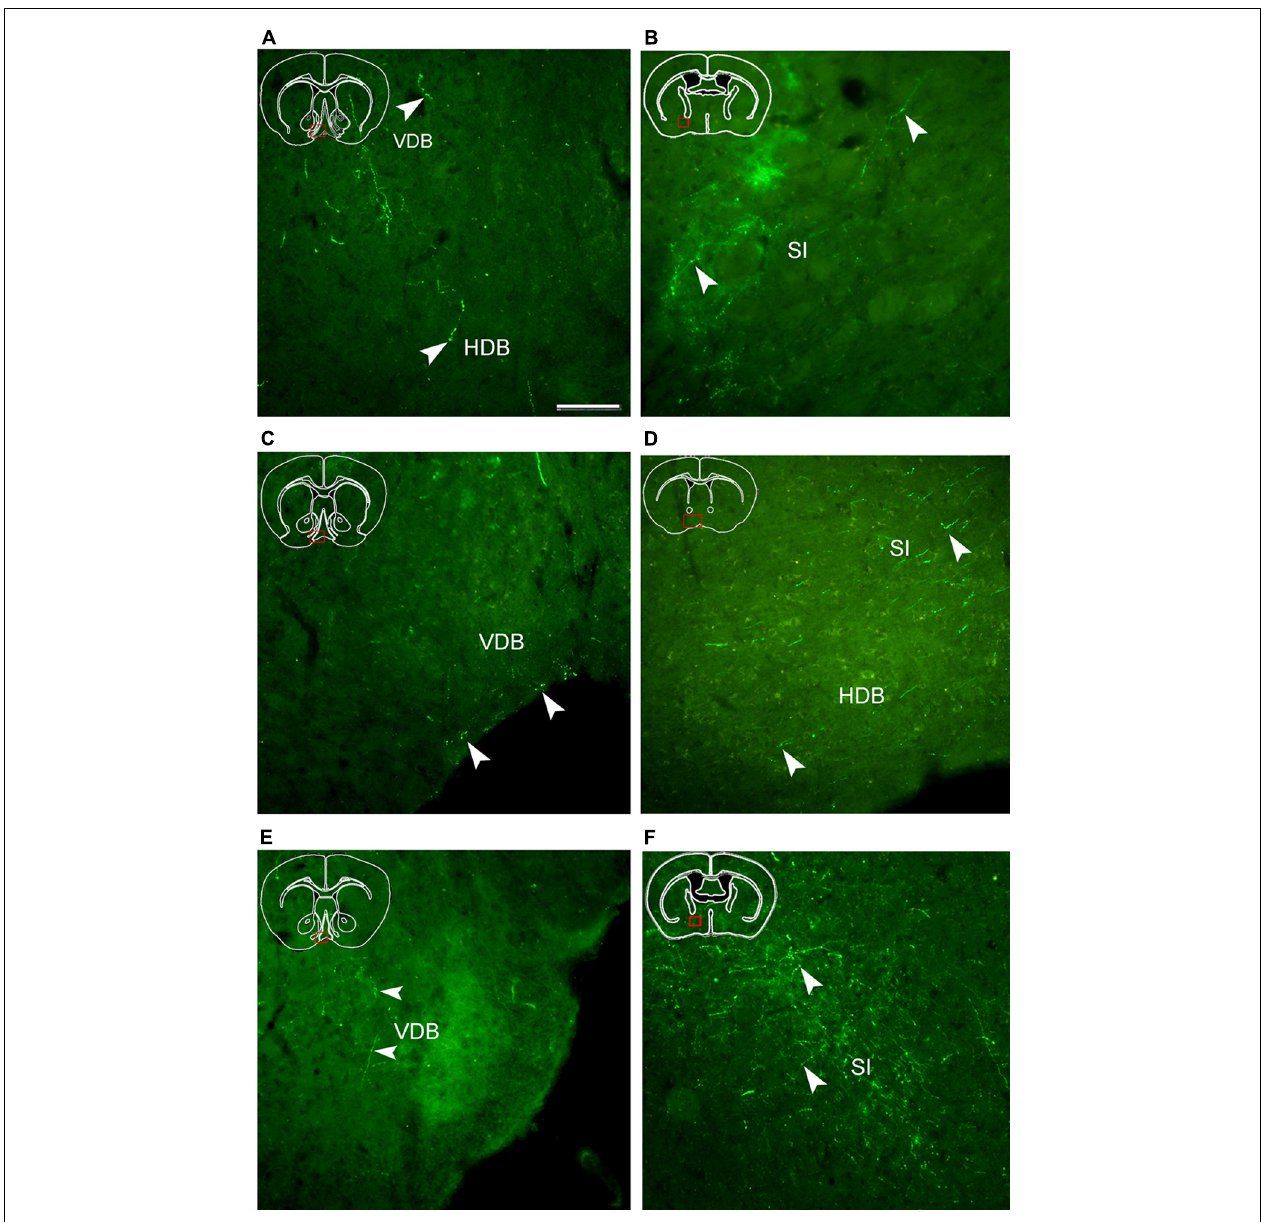
FIGURE 5 | Fluorescent images showing hrGFP-IR fibers and termini from the AcbC (A,B; M-7), medial AcbSh (C,D; M-11), and ventral AcbSh (E,F; M-21) injections. Axons with varicosities invade the nucleus of the vertical limb of the diagonal band (VDB; A,C,E) , the nucleus of the horizontal limb of the diagonal band (HDB; A,D) , and the substantia innominate (SI; B,D,F) . (A,B) hrGFP-IR axons and termini in the VDB, the